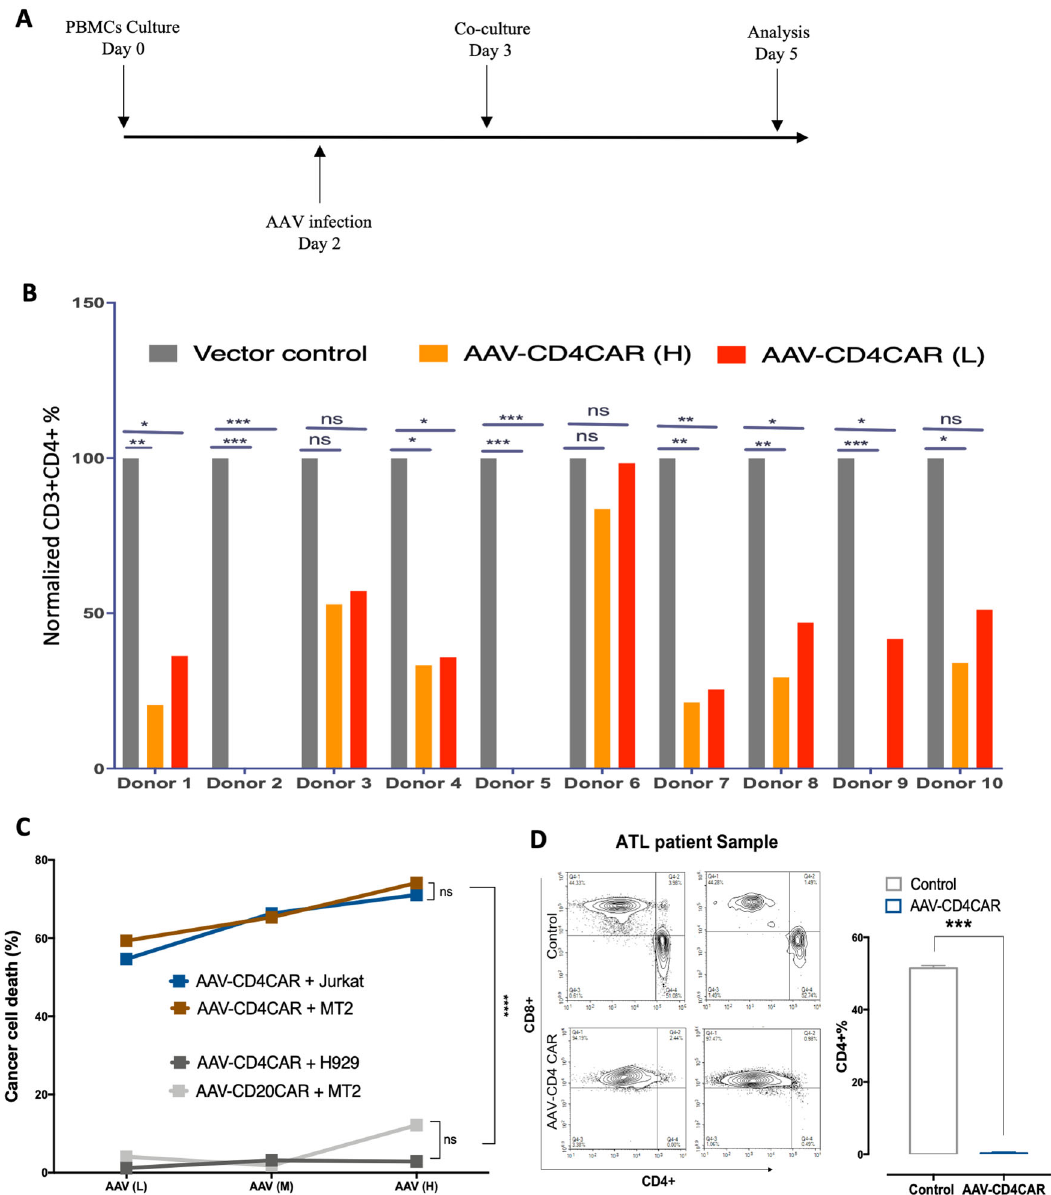
Fig. 2 AAV-CD4CAR induces antitumor activity. A Schematic representation showing the ex vivo AAV-CAR production and co-culture assays. B AAV-CD4CAR depleted CD3 + CD4 + cells in different donors ( n = 10) during the course of T-cell expansion. Activated PBMCs from each donor were transduced with different doses of AAV-CD4CAR, and Vector control (untransduced). After 48 h, the cells were analyzed by FACS using anti-human CD4, anti-human CD3, and anti-human CD8 antibodies. The CD3 + CD4 + percentage was normalized to the vector control group (which represented 100%), and the CD3 + CD4 + percentages of AAV-CD4CAR (H) and AAV-CD4CAR (L) was calculated by the percent difference from the vector control group. A two-way ANOVA multiple comparisons test within each donor was used for statistical analysis. ns, no signi fi cance; *** P < 0.001; ** P < 0.01; * P < 0.05. C AAV-CD4CAR T cells were co-cultured with CFSE-stained target cells, 48 h post-co-culture, cells were stained with 7-AAD and analyzed by FACS. Two-way ANOVA with the multiple comparisons test was used to assess signi fi cance, ns, no signi fi cance; **** P < 0.0001. *** P < 0.001; ** P < 0.01; * P < 0.05. D ATL patient PBMCs were infected with AAV-CD4CAR (H) and with a control vector (samples were duplicated). Forty-eight hours post-transduction, cells were analyzed by FACS for CD3 + CD4 + depletion. An unpaired two-tailed t -test was used to calculate the signi fi cance of the difference. AAV-CD4CAR vs vector control, *** P < infusion (Fig. 3B, C). Correspondingly, CD3 + CD4 + cells started with AAV-CD4CAR. This amount corresponds to the approved high decreasing within the fi rst week in the positive control and dose of CAR T cells currently being used in clinics, in which treatment groups. After two weeks, there was a signi fi cant patients are administered 1.2 × 10 7 CAR T cells/kg of mean difference in CD3 + CD4 + cell percentage between the positive bodyweight [19]. However, we infused a single dose of 1 × 10 11 control and treatment group compared to the negative control AAV into the treatment group (AAV-CD4CAR) and a negative and untreated mice (Fig. 4D). However, there was no difference control group (AAV-CD20CAR). As envisioned, a single dose of AAV observed between the positive control and the treatment group, (1 × 10 11 ) infusion was able to yield enough AAV-CD4CAR T cells suggesting that the targeting potential of the in vivo-generated in vivo, similar to the number of ex vivo-transduced cells after